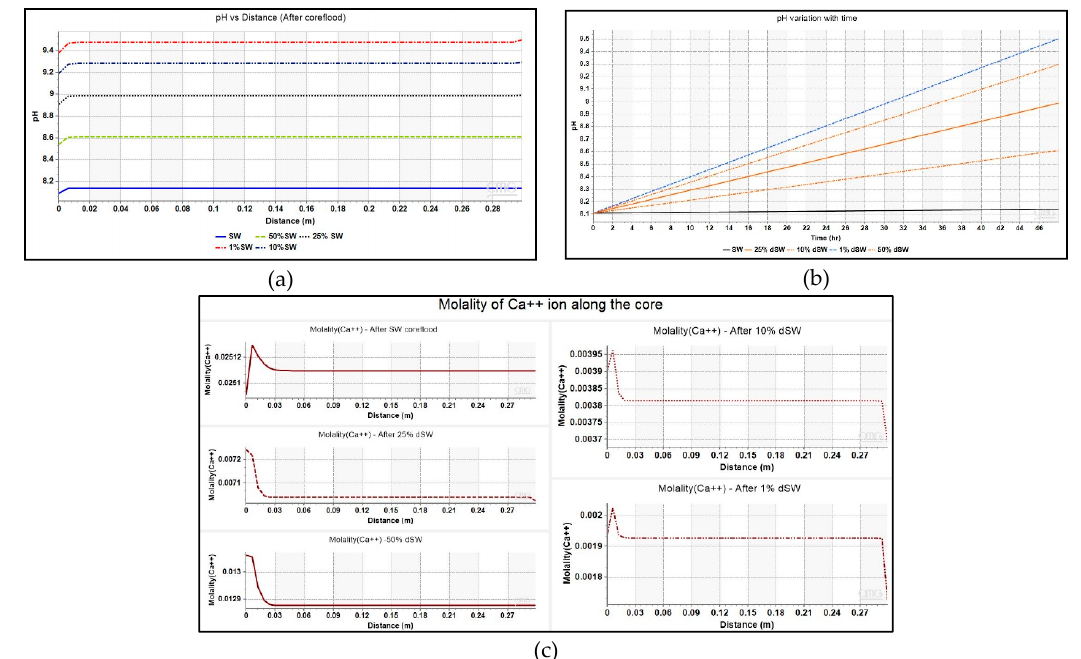
Figure 7. (a)Trend of pH variation with distance (injector to producer) for coreflooding with different low-salinity brines, (b) pH change of brine inside the core as a function of injection time, and (c) Molality of Ca 2+ ion as a function of lateral distance along the core for various diluted brines. Energies 2021 , 14 , x FOR PEER REVIEW